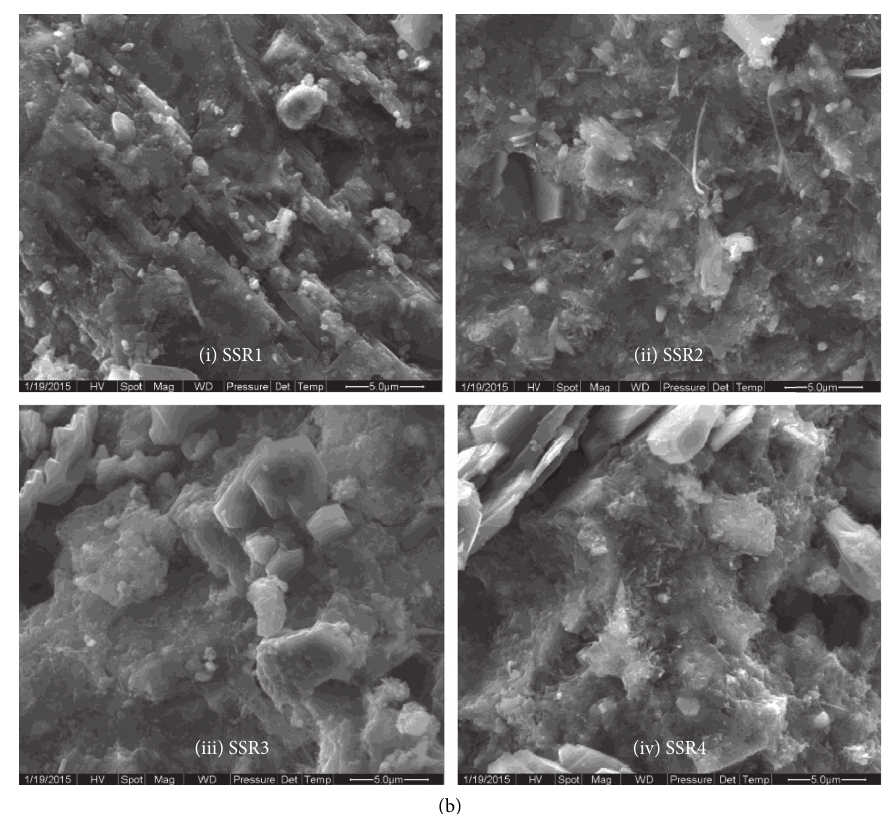
Figure 16: Morphology of blended cement containing steel slag powder with different sizes. (a) 3d. (b)